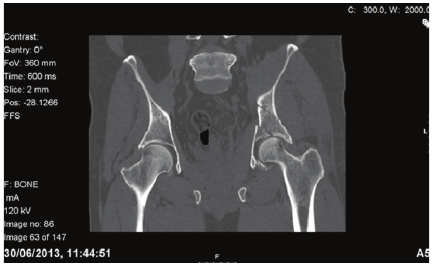
Figure 3: A coronal CT reconstruction suggesting medial subluxa- tion of the femoral